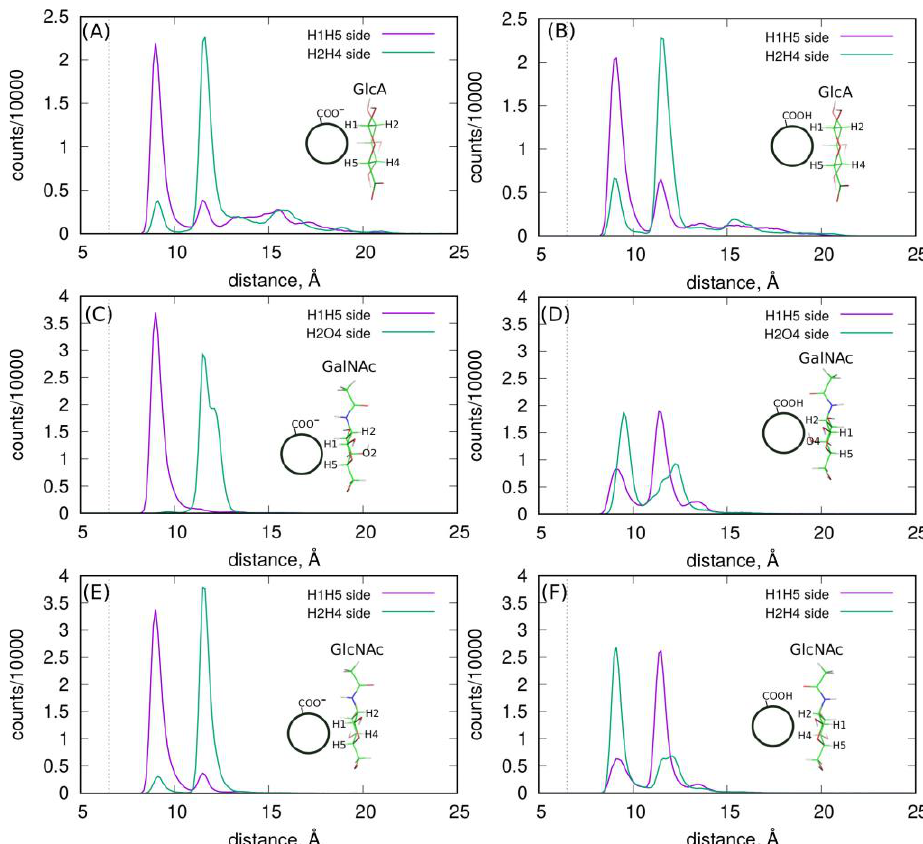
Figure 5. The density profiles of monosaccharide H1-H5 and H2-H4(O4) atoms in each molecular system. Parts ( A , B ) are for GlcA, parts ( C , D ) are for GalNAc and parts ( E , F ) are for GlcNAc. The insets in each graph show the observed preferred orientation of the monosaccharide in reference to the fCNT surface. These orientations correspond to the pair of atoms, for which the first peak appears on the density distribution.